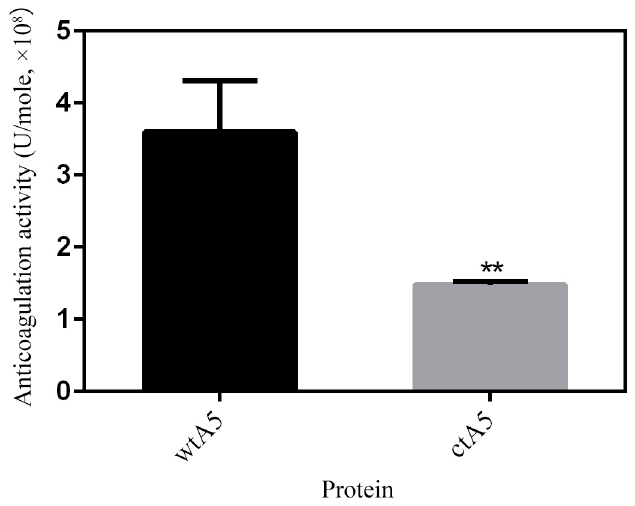
Figure 8. APTT assay of wtA5 and ctA5 proteins. The anticoagulation activity of ctA5 was significantly ( p = 0.0068, n = 3) lower than that of wtA5.